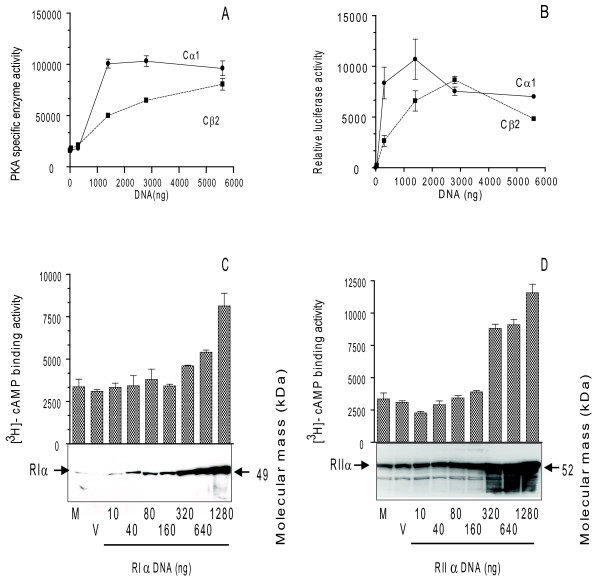
Activity of PKA R and C subunits expressed in 293T cells. (A and B) 293T cells were left untransfected, transfected with empty vector (vector) or with increasing amounts (0 - 5600 ng) of either pDeCα1 (Cα1, —) or pDeCβ2 (Cβ2, ------). After 24 hours cells were harvested, homogenized and all cell extracts adjusted to 1 mg total protein/mL. PKA activity was determined as catalytic activity against Kemptide in the presence of 7.14 μM cAMP (A) and Luciferase activity at 560 nm (B). Data points represent enzyme activity and relative luciferase activity, respectively, +/- SD, n = 3. (C and D) 293T cells were left untransfected, transfected with empty vector (vector) or with increasing amounts (10 - 1280 ng) of either pDeRIα or pExRIIα. Levels of R subunit expression were monitored as [3H]-cAMP-binding and R subunit immunoreactivity against RIα (C, clone 4D7, 1: 300 dilution) or anti-RIIα (D, 1 : 400 dilution) after SDS-PAGE separation of 25 μg total protein per lane in 12.5 % gels. R subunit activities are given as cpm +/- SD (n = 3). The apparent molecular weight of protein recognized is indicated by arrows and protein identity RIα (49 kDa) and RIIα (52 kDa), given by arrows to the left. One immunoblot out of three independent experiments is shown.